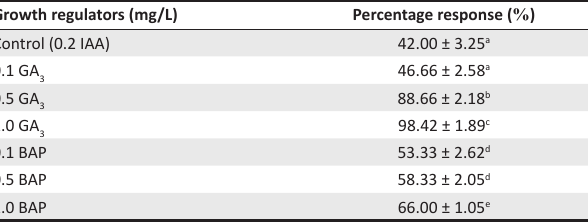
TABLE 3: Effect of different concentrations of gibberellic acid and benzyl aminopurine in combination with indole acetic acid in Murashige and Skoog